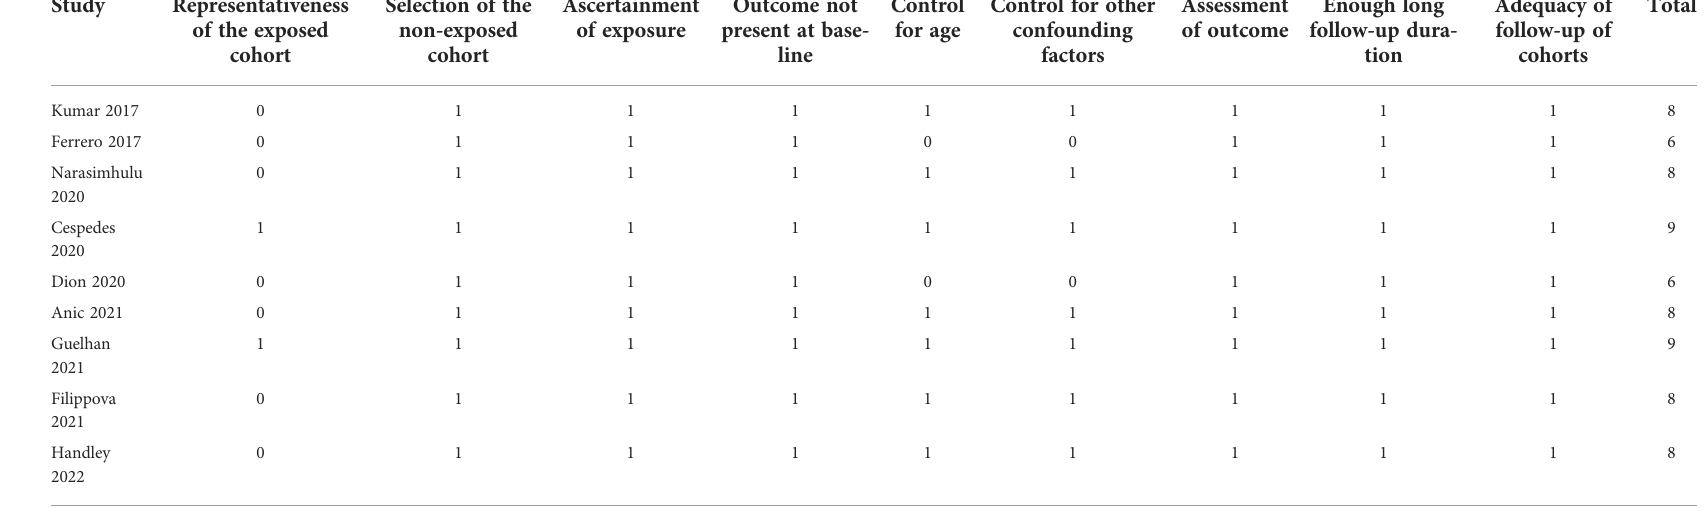
TABLE 2 Quality evaluation of the included